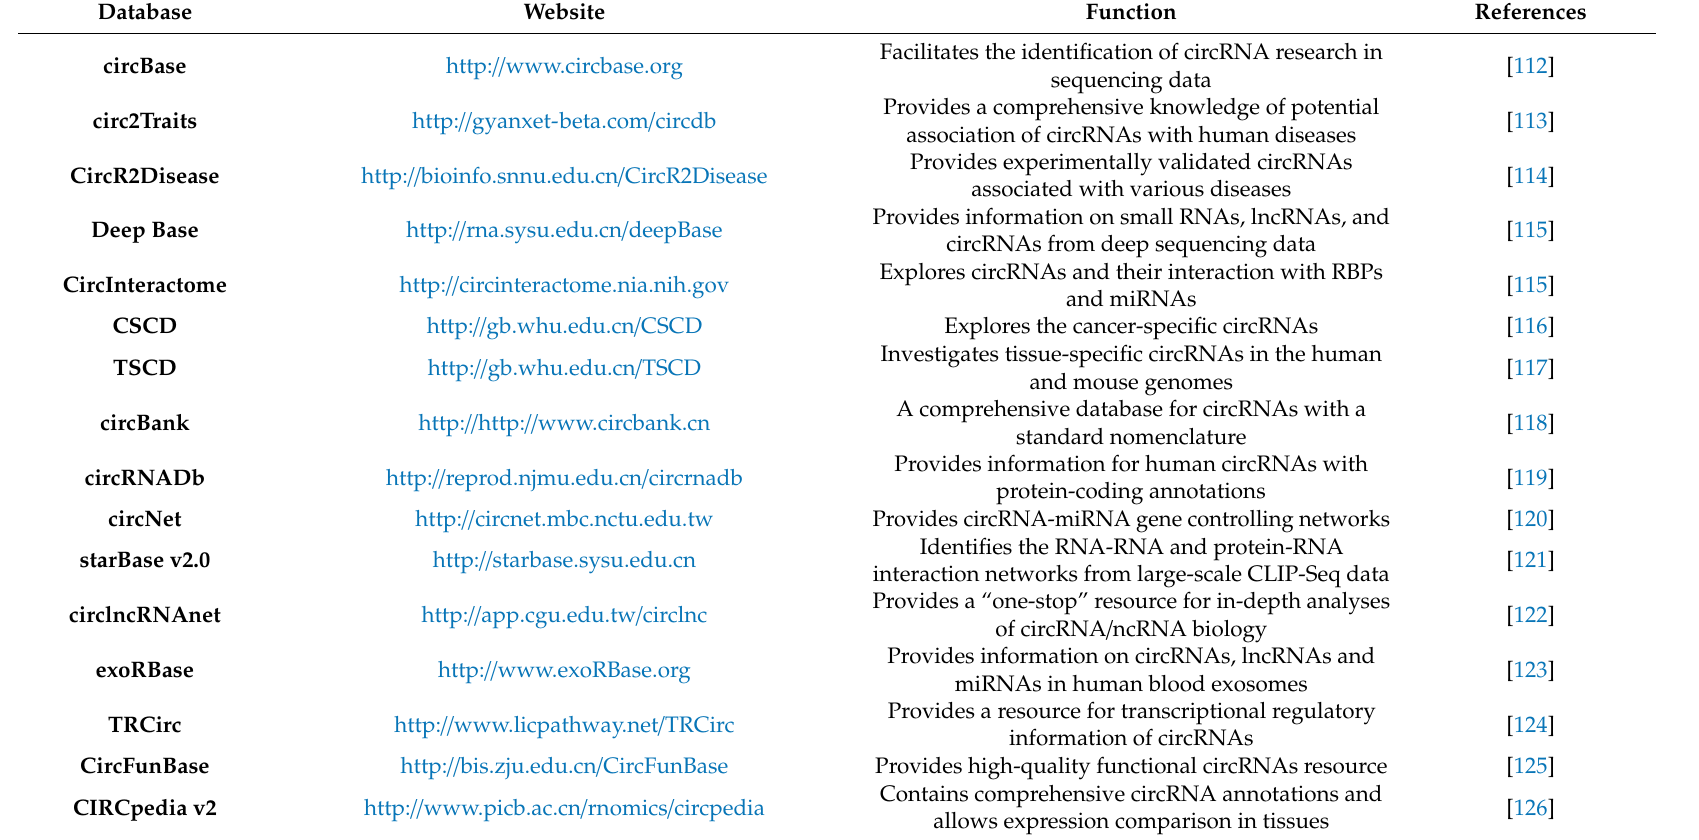
Table 1. List of the main circRNA databases available